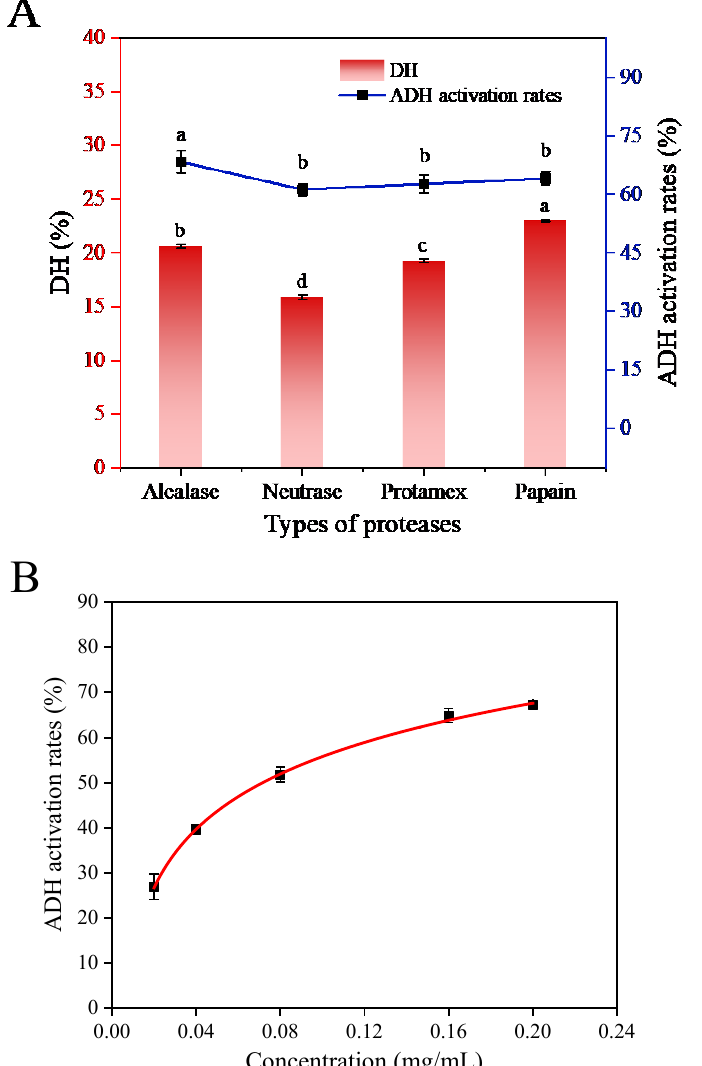
Figure 1. ( A ) ADH activation rates and DH of different proteases on hydrolysis of chickpea. ( B ) Concentration for 50% of maximal effect (EC50) values for ADH activation by CPHs. (Different letters (a–d) represent significant differences in values) .